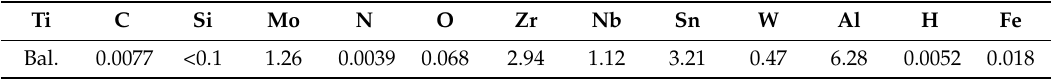
Table 1. Chemical composition of BTi-6431S high temperature titanium alloy (wt